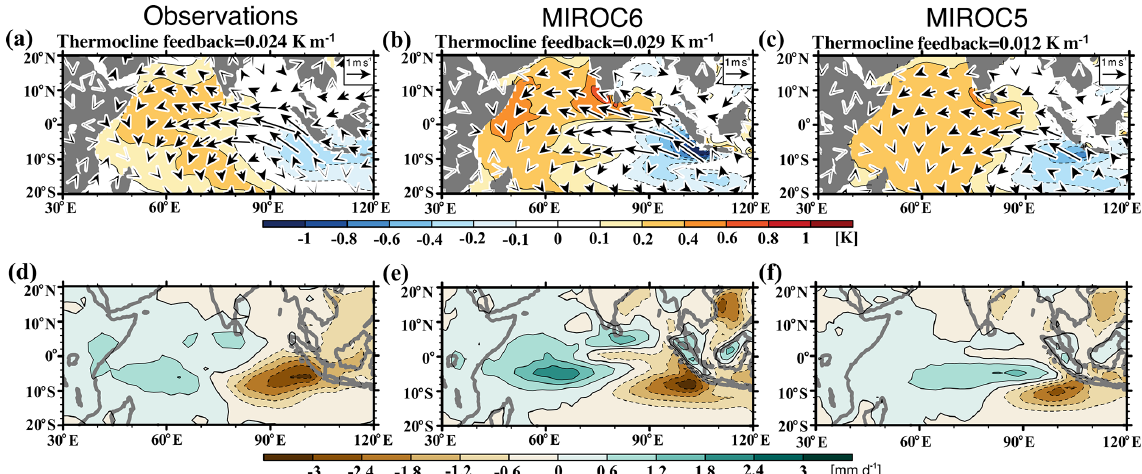
Figure 27. Same as Fig. 26, but for anomalies of SST (colors), 10m wind vectors (a, b, c) , and precipitation (d, e, f) regressed onto the autumn DMI. The values of the regression slope between anomalies of the 20 ◦ C isotherm depth and the SST over the eastern IOD region, which indicates the thermocline feedback, are displayed on the top of (a, b, c) .